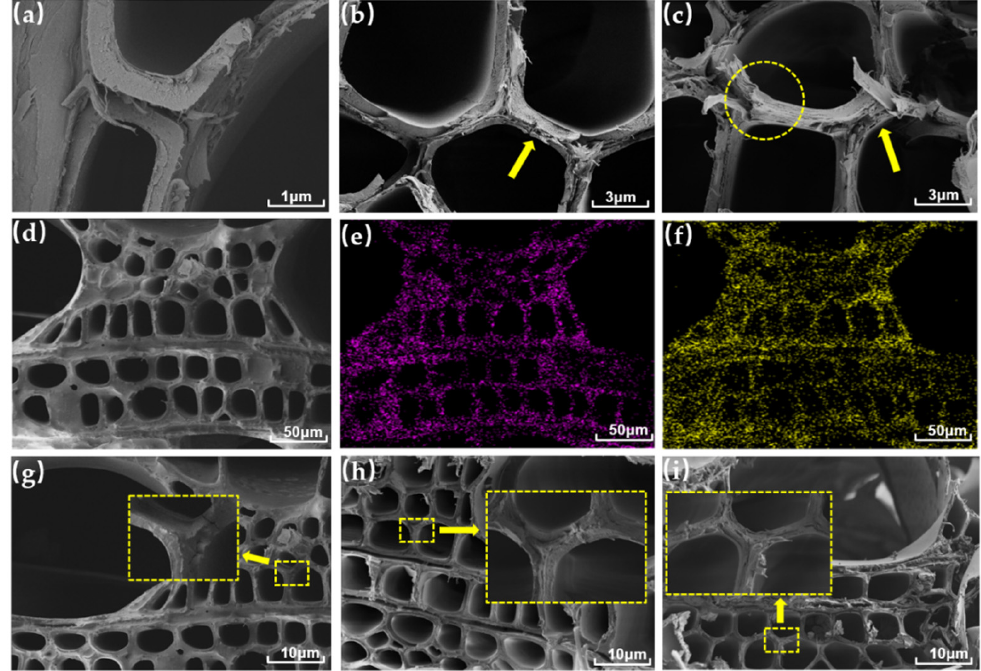
Figure 3. ( a ) Untreated sample. ( b ) HT-160 °C sample. ( c ) HT-220 °C sample. ( d ) Sample with only impregnation pretreatment with 0.05 mol/L AlCl 3 . ( e ) Al element in panel d. ( f ) Cl element in panel ( d ). ( g ) Sample impregnated only with 0.05 mol/L AlCl 3 . ( h ) 0.05 M-160 °C sample. ( i ) 0.5 M-160 °C sample.